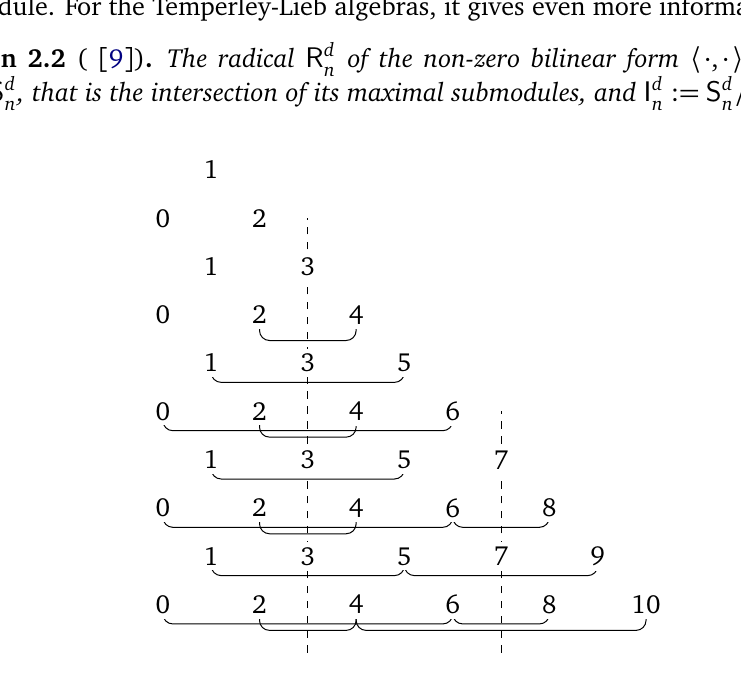
for (cid:96) = 4 with n = 1 as the top n